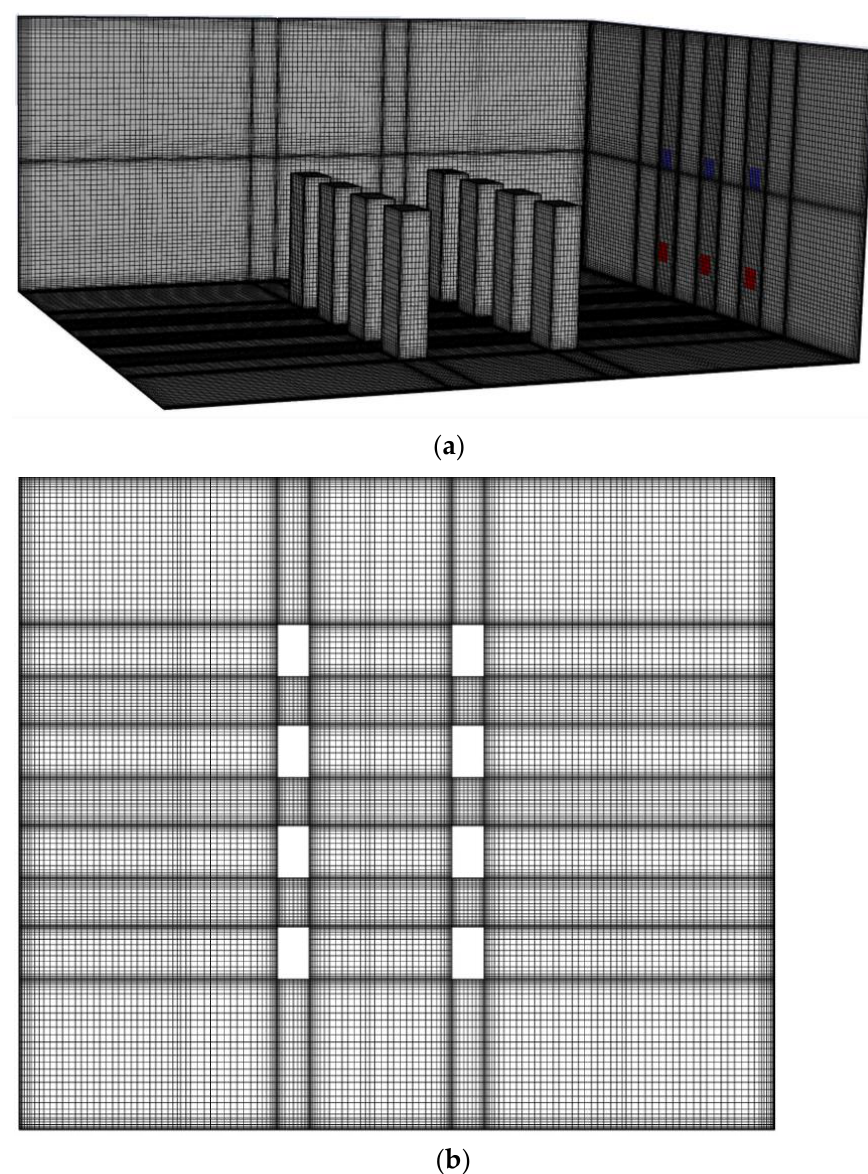
Figure 5. Mesh of computational domain: ( a ) 3D mesh; ( b ) Z = 1.1m.